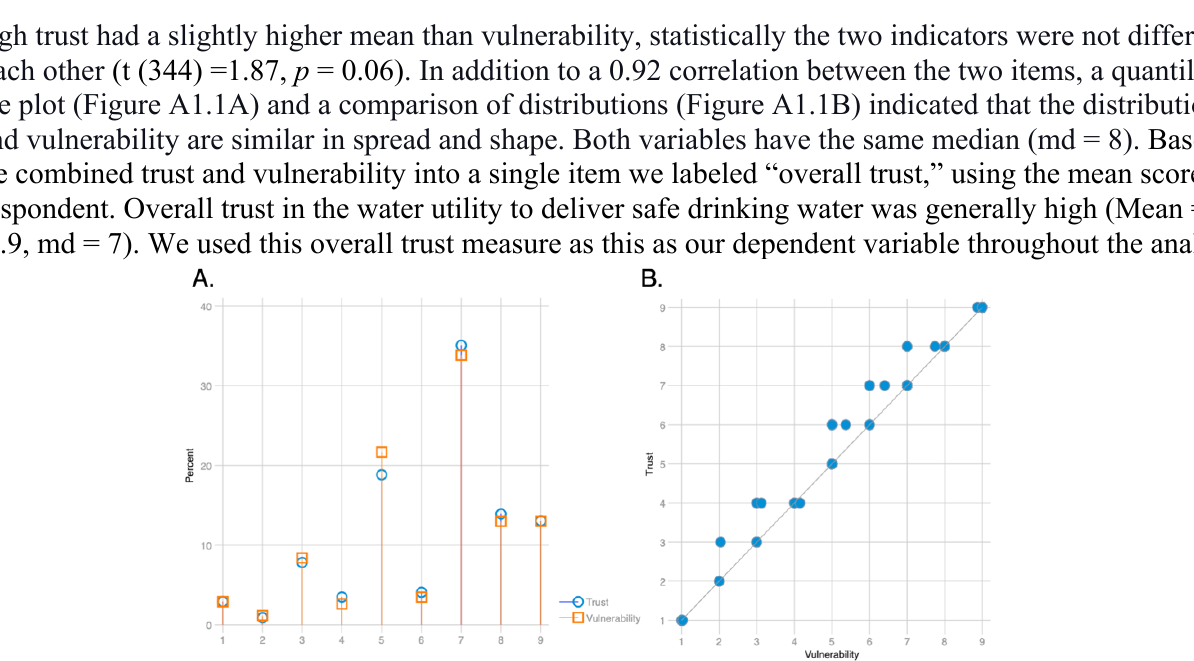
Figure A1.1 Visual inspection of trust and vulnerability indicators using a histogram (A) and a q-q plot (B) suggest a similar distribution across indicators